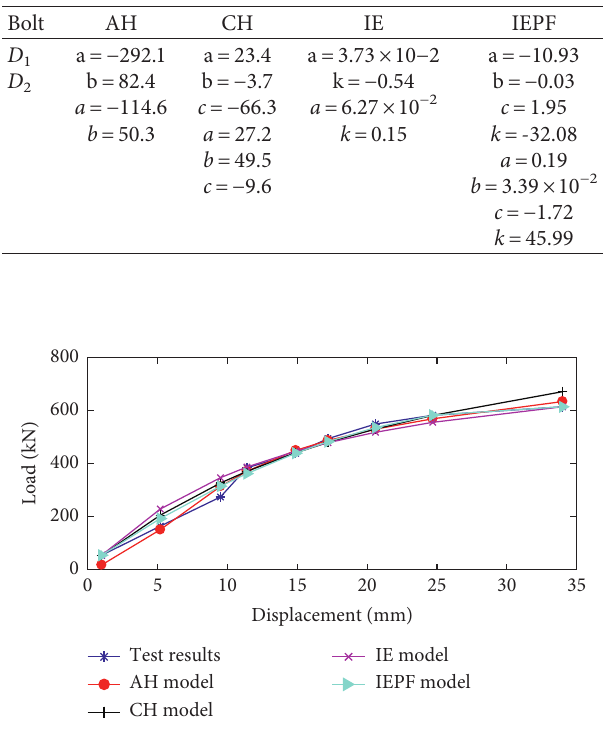
Figure 9: Comparison of each model with the test data from D